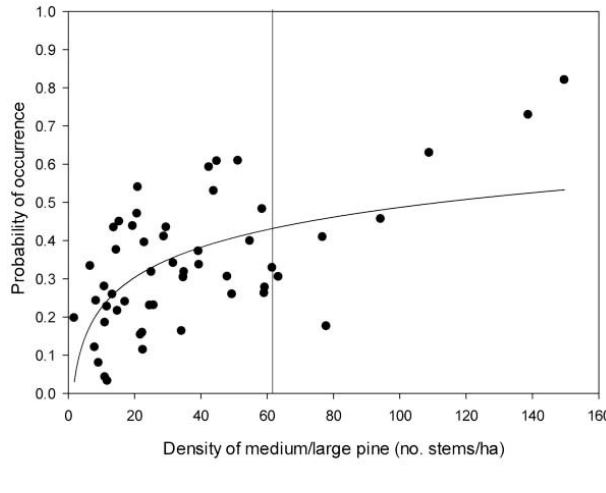
Fig. 6 . Relationship between the density of medium/large pine trees and the probability of occurrence of Brown Creeper in pine forests. Threshold derived from ROC curve is shown as vertical line (see Methods).